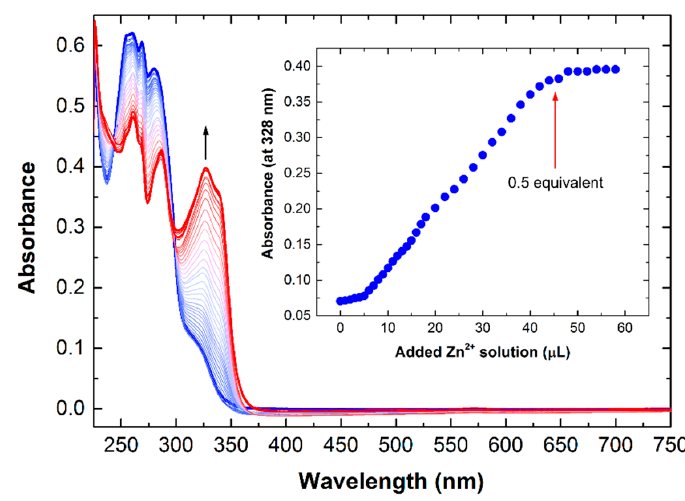
Figure 3. UV-Vis spectrophotometric titration of tpy-PS 1 -PEG 43 with a concentrated solution of Zn(OTf) 2 in dichloromethane. The arrow indicates the number of added equivalents corresponding to the polymer 2:1 metal stoichiometry, in agreement with the M(tpy-PS 1 -PEG 43 ) 2 formulation.